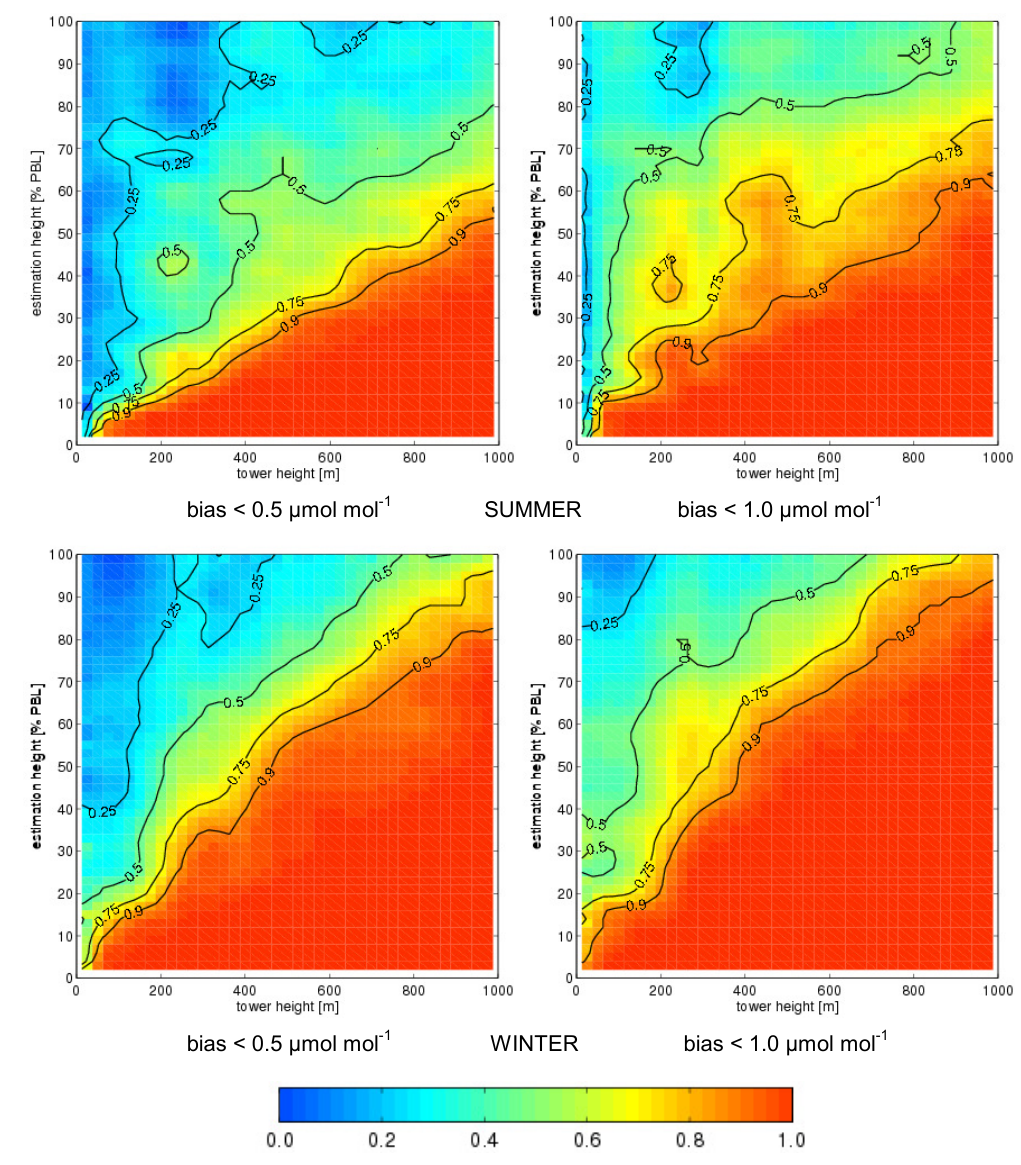
Figure 3. Empirical probability of the cases when the bias between the true CO 2 mole fraction and the estimated (extrapolated) one does not exceed 0.5 (left) or 1.0µmolmol − 1 (right) as the function of the height of the hypothetical tower and the estimation height relative to the height of the PBL in summer (top) and winter